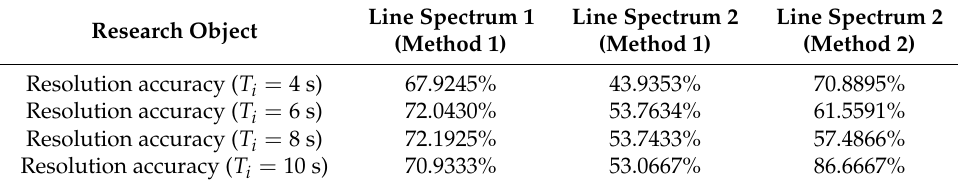
Table 8. Target category-resolution accuracy (830–1200